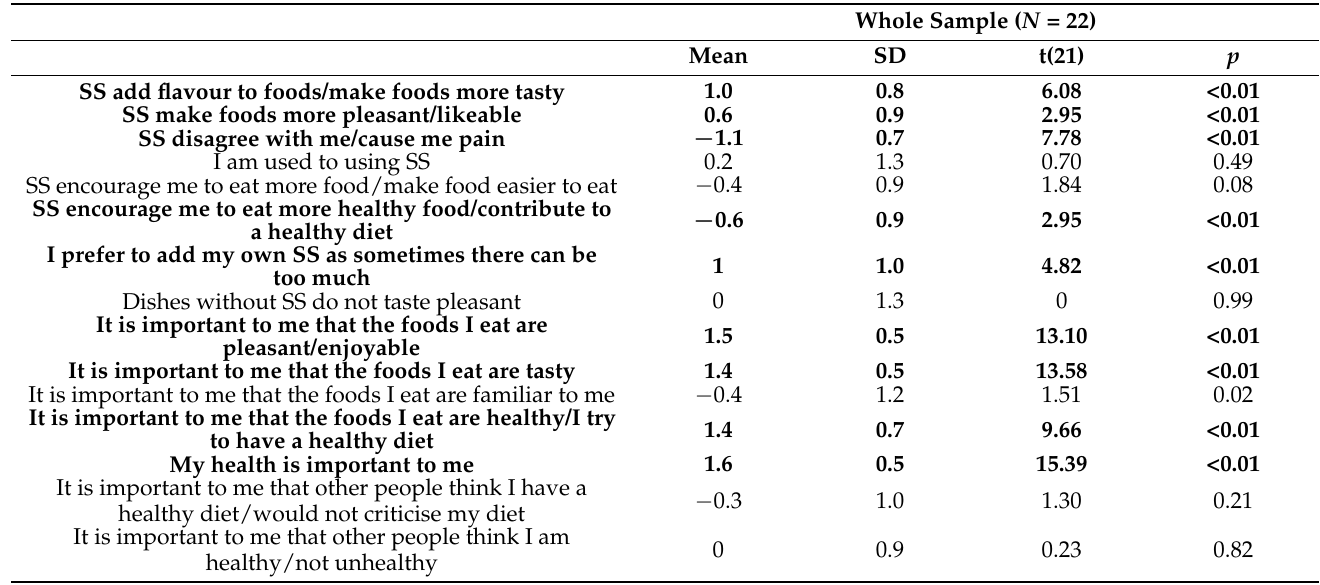
Table 2. Mean, SD score from − 2 to +2 for all attitudinal statements in the questionnaire on sauce and seasoning use and attitudes, in the sample as a whole ( N = 22). Statistics ( t values) demonstrate a difference from 0 (no